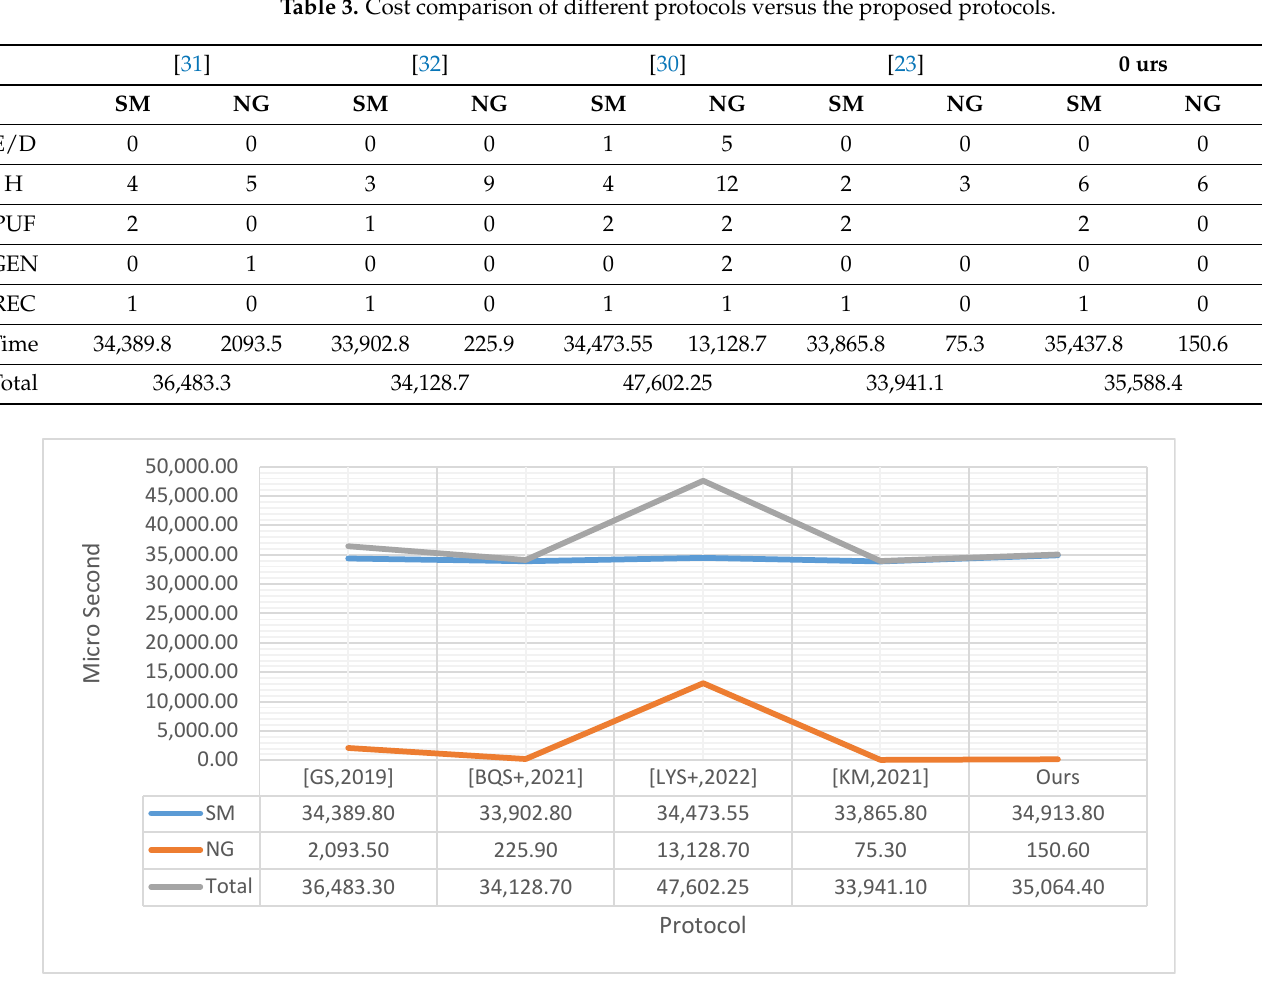
Figure 3. Comparison of the computational cost of the proposed protocol and related